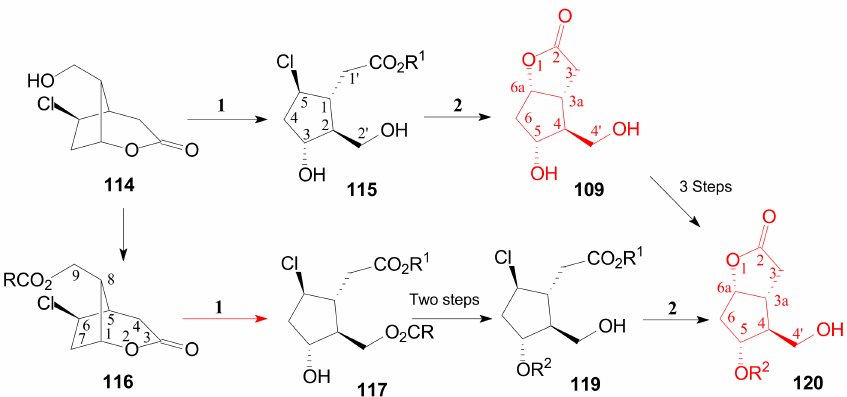
Scheme 25. Synthesis of γ -lactones 109 and 120 from δ -lactone 114 . The selective protec- tion/deprotection of the primary and secondary alcohols in three steps to the mile stone Corey lactone used for building of ω -side chain (in red).